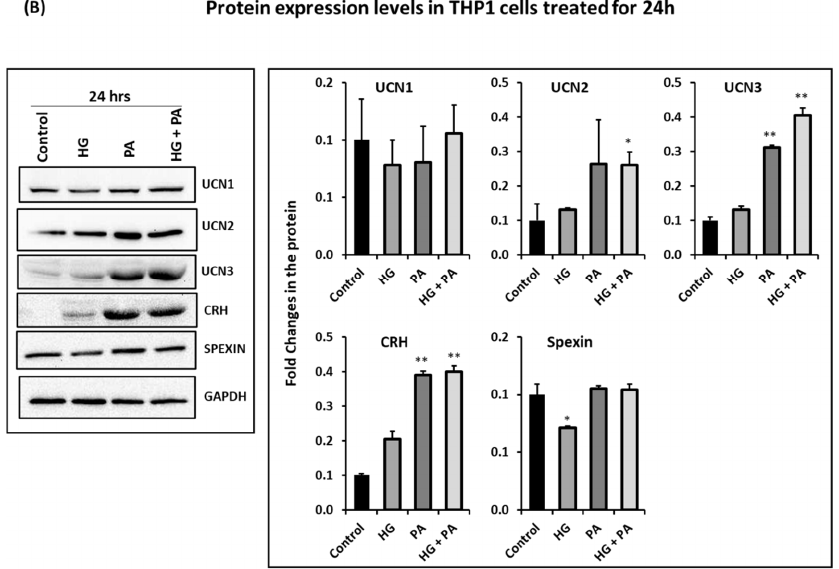
Figure 3. Gene and protein expression levels in THP1 cells treated for twenty-four hours. mRNA ( A ) and protein ( B ) expression levels of UCN1, UCN2, UCN3, CRH, and Spexin were respectively measured by quantitative real-time PCR and Western blots in THP1 cells treated with high glucose (25 mM), palmitate (200 µM) and the combination for 24 h ( n = 3 for each condition). Data are nor- malized to internal GAPDH and presented as fold-change compared with control data. One-way ANOVA with repeated measurements followed by Sidak´s post hoc test were used to determine the significance of the differences in means between the groups (* p < 0.05, ** p < 0.01, *** p < 0.001). To elucidate whether the impact of metabolic stress on neuropeptide expression was related to endoplasmic reticulum (ER) stress and inflammatory markers commonly in- creased during obesity, THP1 cells were treated with either HG, PA, or their combination for 4 and 24 h, and the mRNA levels of selected genes were measured. After a 4 h treat- ment, an increase in expression was observed for most genes examined, especially in re- sponse to the HG and PA combination (Figure 4). However, a more pronounced increase in expression of inflammatory markers (tumor necrosis factor (TNF α ), interleukin-10 (IL10), interleukin-6 (IL6), and chemokine C-C motif ligand 2 (CCL2)) as well as ER stress markers ((activating transcription factor 6 (ATF6), protein kinase R (PKR)-like endoplas- mic reticulum kinase (PERK), Inositol-requiring enzyme 1 (IRE1), protein kinase RNA- activated (PKR), and C/EBP homologous protein (CHOP)) was observed in response to PA treatment for 24 h ( p < 0.001, Figure 5). However, only marginal effects were observed on these markers in the presence of HG alone, whereas increased expression of the inflam- matory markers, IL10, IL6, and CCL2, were observed in response to combined exposure of THP1 cells to HG and PA. This effect was also further exacerbated for the ER stress markers, ATF6, PERK, IRE1, PKR, and CHOP, in response to the combined treatment (Fig- ure 5).